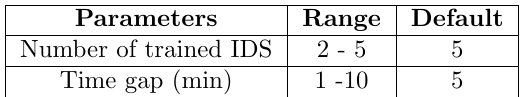
Table 2. Simulation Parameters